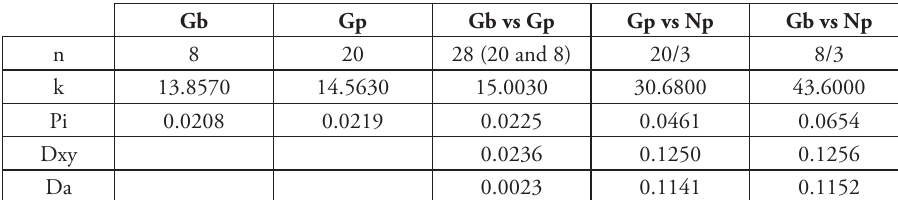
Table 2. Nucleotide diversity between G. pierai , G. barrerai and N. perotensis . Gb Gp Gb vs Gp Gp vs Np